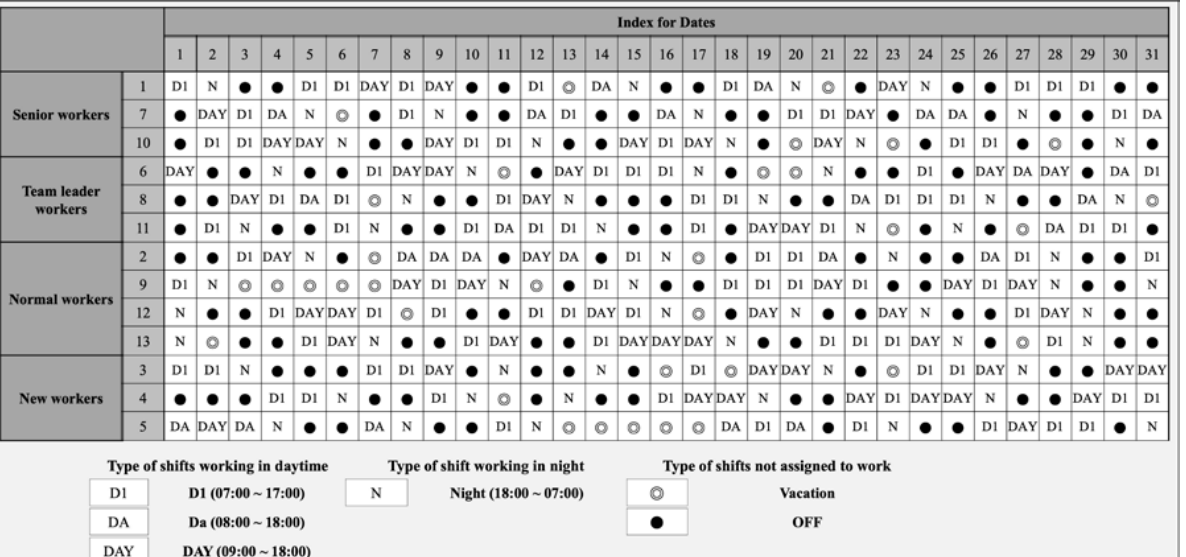
Figure 5. Change in preferred shift placement number for each worker. The average is very low in the case of the third preferred shift in the new schedule, which is 1.69, but it widely ranges from 0 to 6. This means there are some cases away from the average, in which most of the values are 0 or 2. According to the rules of the welfare facility, shift D1 needs 3 workers, shift DA needs 0 to 1 worker, and shift DAY needs 1 to 4 workers. The workers who are excessively allocated to the third preferred shift have shift D1 in common in the third priority. This is the result that they choose shift D1 as the third priority, which is not flexible. It happens because the demand, which is the workers’ preference for shifts, is inconsistent with the supply, which is a rule of the facility for